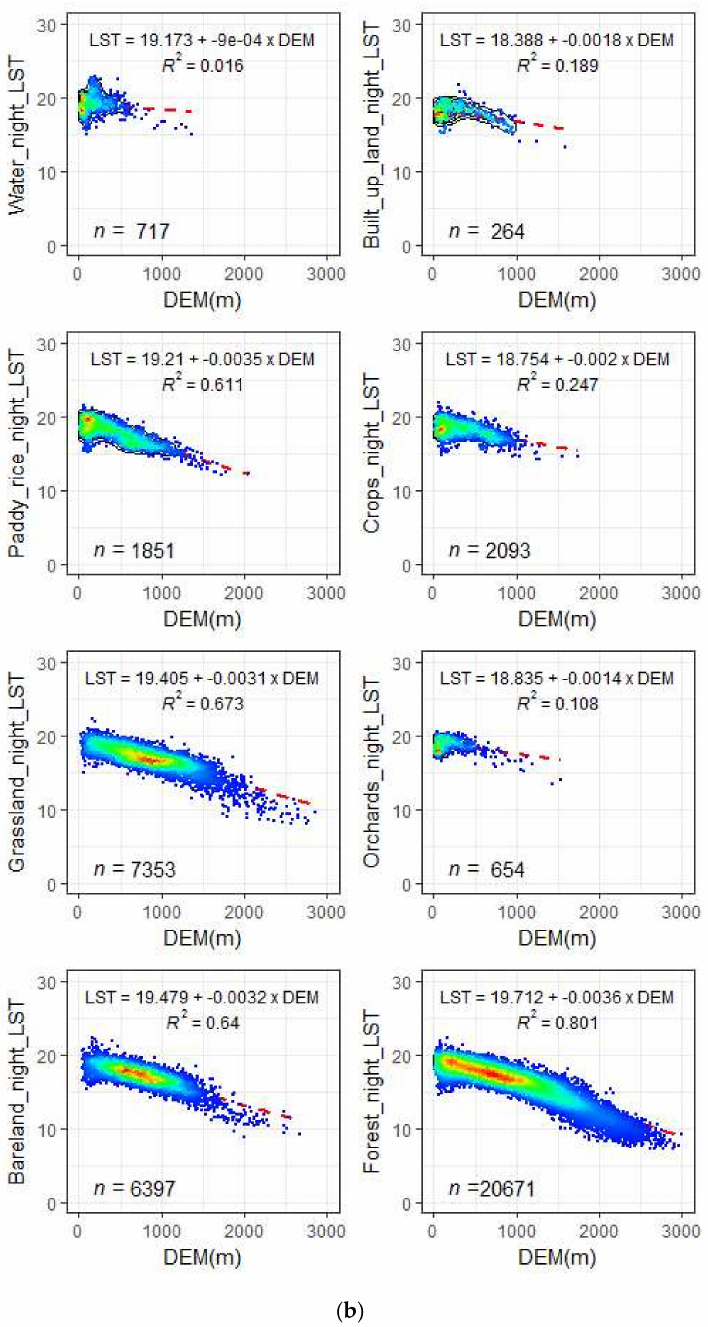
Figure 5. ( a ) Scatter plots showing the relationship between average monthly daytime LST of different land cover types and elevation in northwest Vietnam in 2015. ( b ) Scatter plots showing the relationship between average monthly nighttime LST of different land cover types and elevation in northwest Vietnam in 2015. The color ramp from blue to red expresses the point density from low to